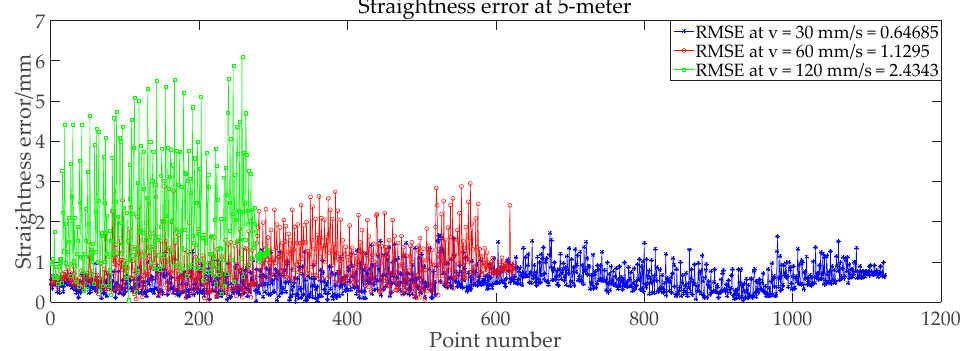
Figure 12. Straightness error of practical trajectory at 5-meter at different speeds.